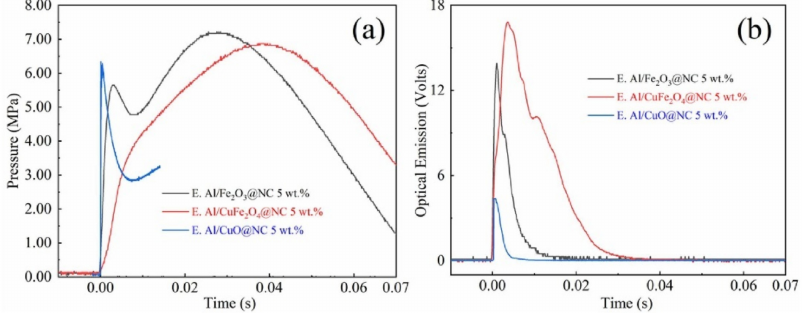
Figure 30. The representative time resolved pressure and optical emission curves of Al/CuO@NC, Al/Fe 2 O 3 @NC and Al/CuFe 2 O 4 @NC composites. ( a , b ) Reproduced with the permission of ref. [149]. Copyright 2022, Fuel.